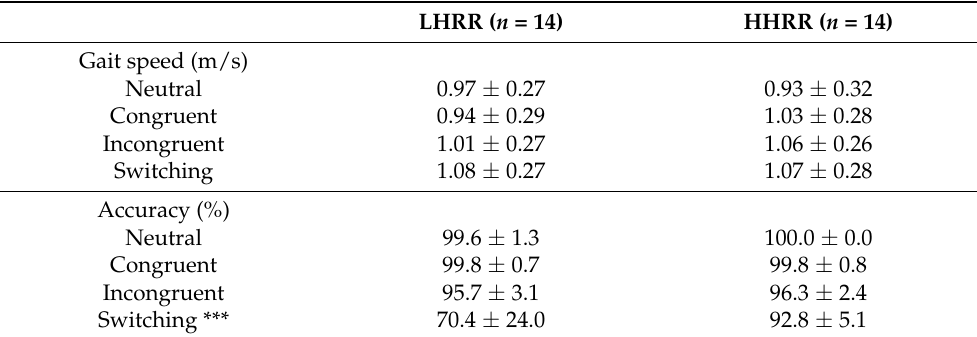
Table 2. Gait speed and accuracy during MSCWT while